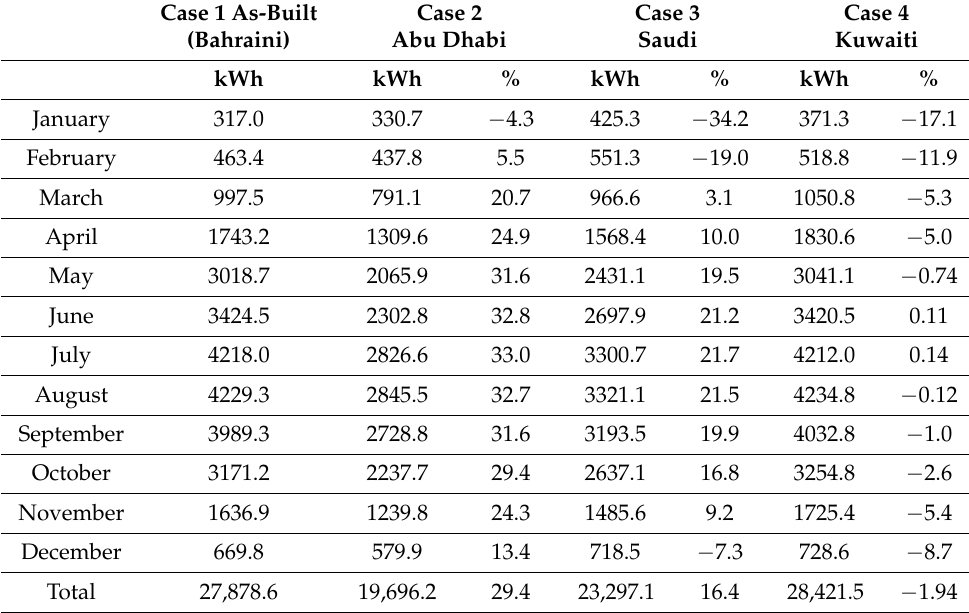
Table 7. Cooling loads and reduction percentages compared to the base case.